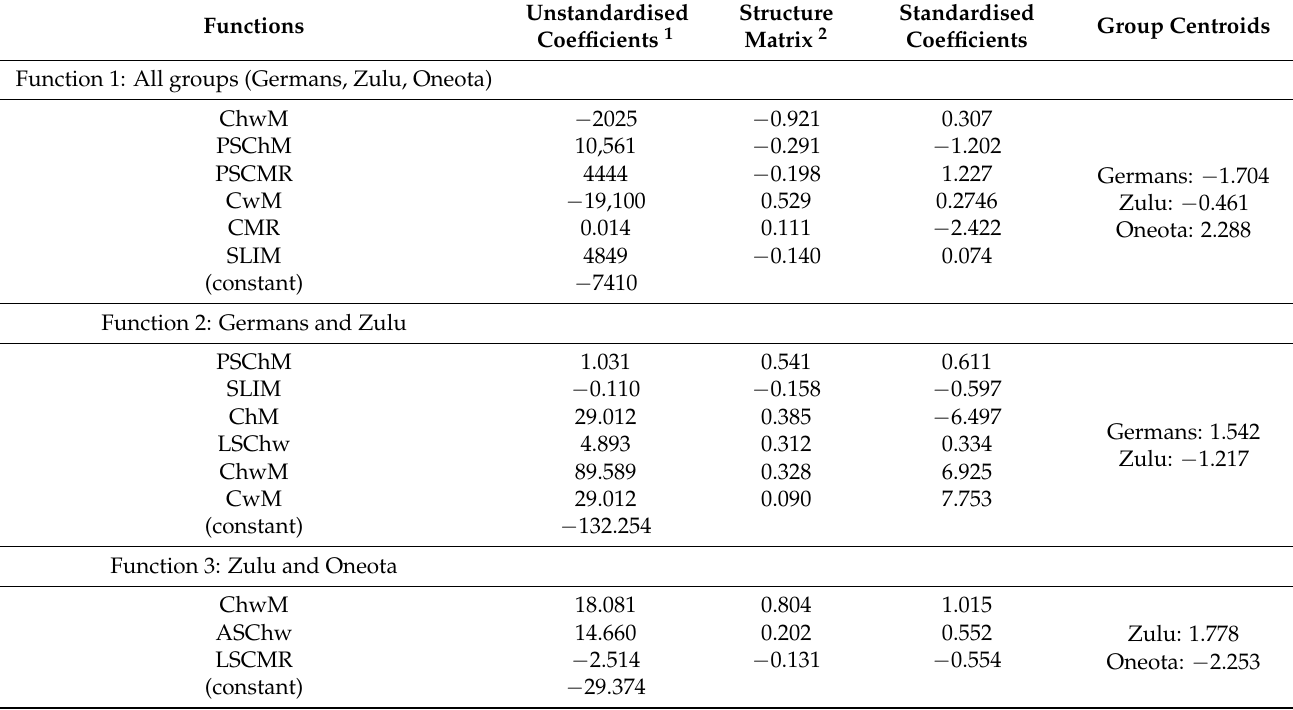
Table 3. Canonical discriminant function